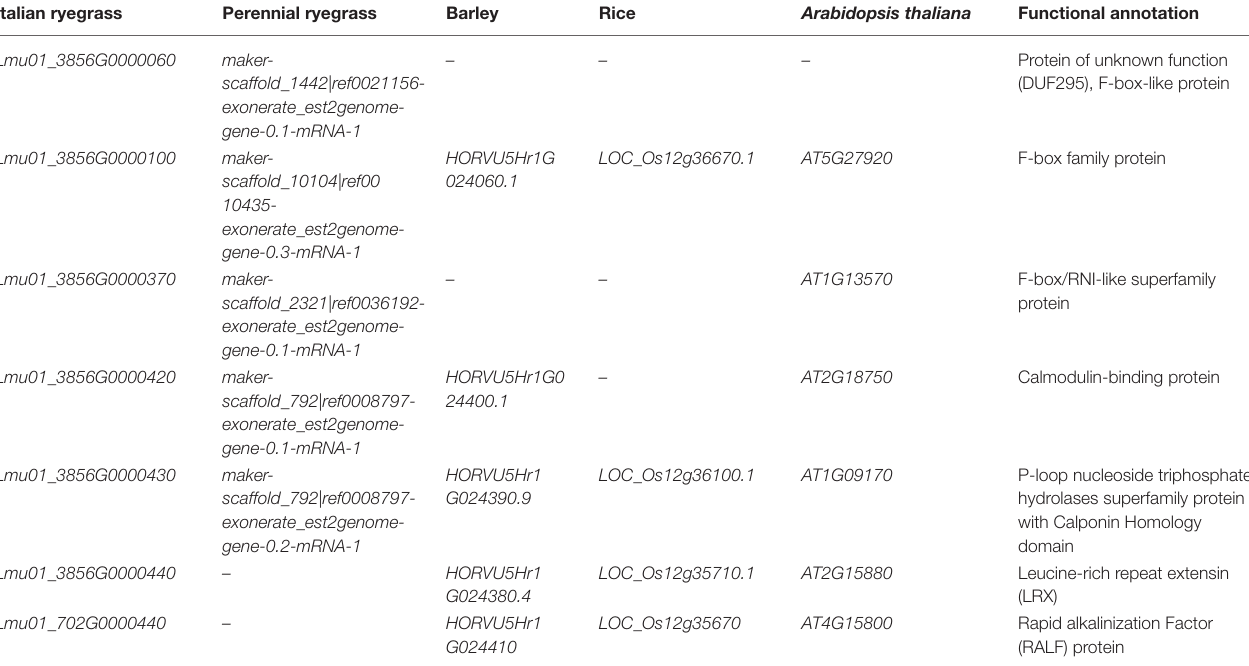
TABLE 2 | List of the seven prioritized candidate genes co-segregating with self-compatibility, their annotation, and orthologs in perennial ryegrass ( Lolium perenne L.), barley ( Hordeum vulgare L.), rice ( Oryza sativa L.), and Arabidopsis thaliana . Italian ryegrass Perennial ryegrass